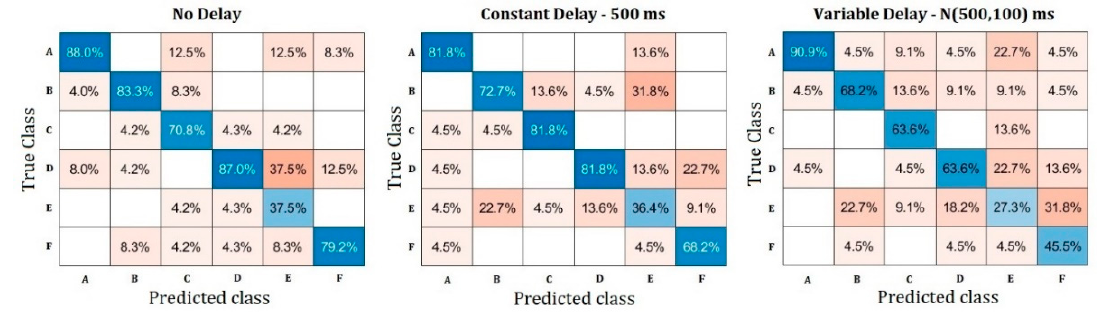
Figure 6. Confusion matrices in the symbol identification test.